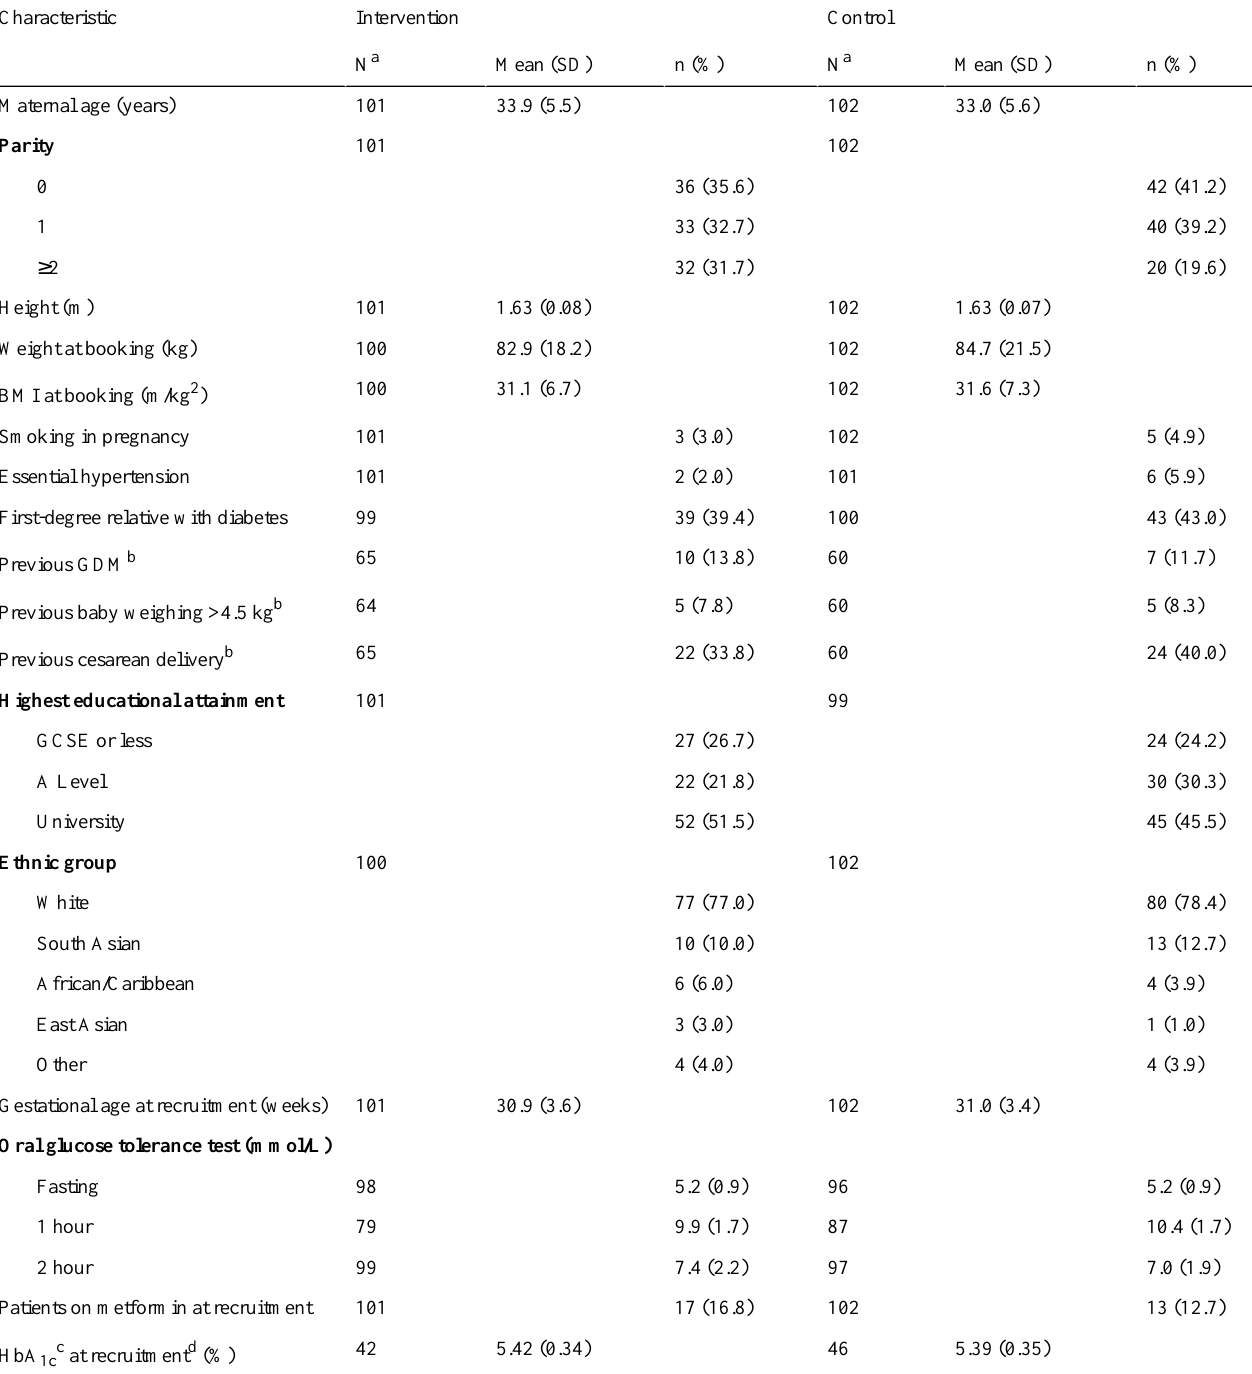
Table 1. Baseline characteristics of participants (N=203). BMI: body mass index; GCSE: General Certificate of Secondary Education; GDM: gestational diabetes